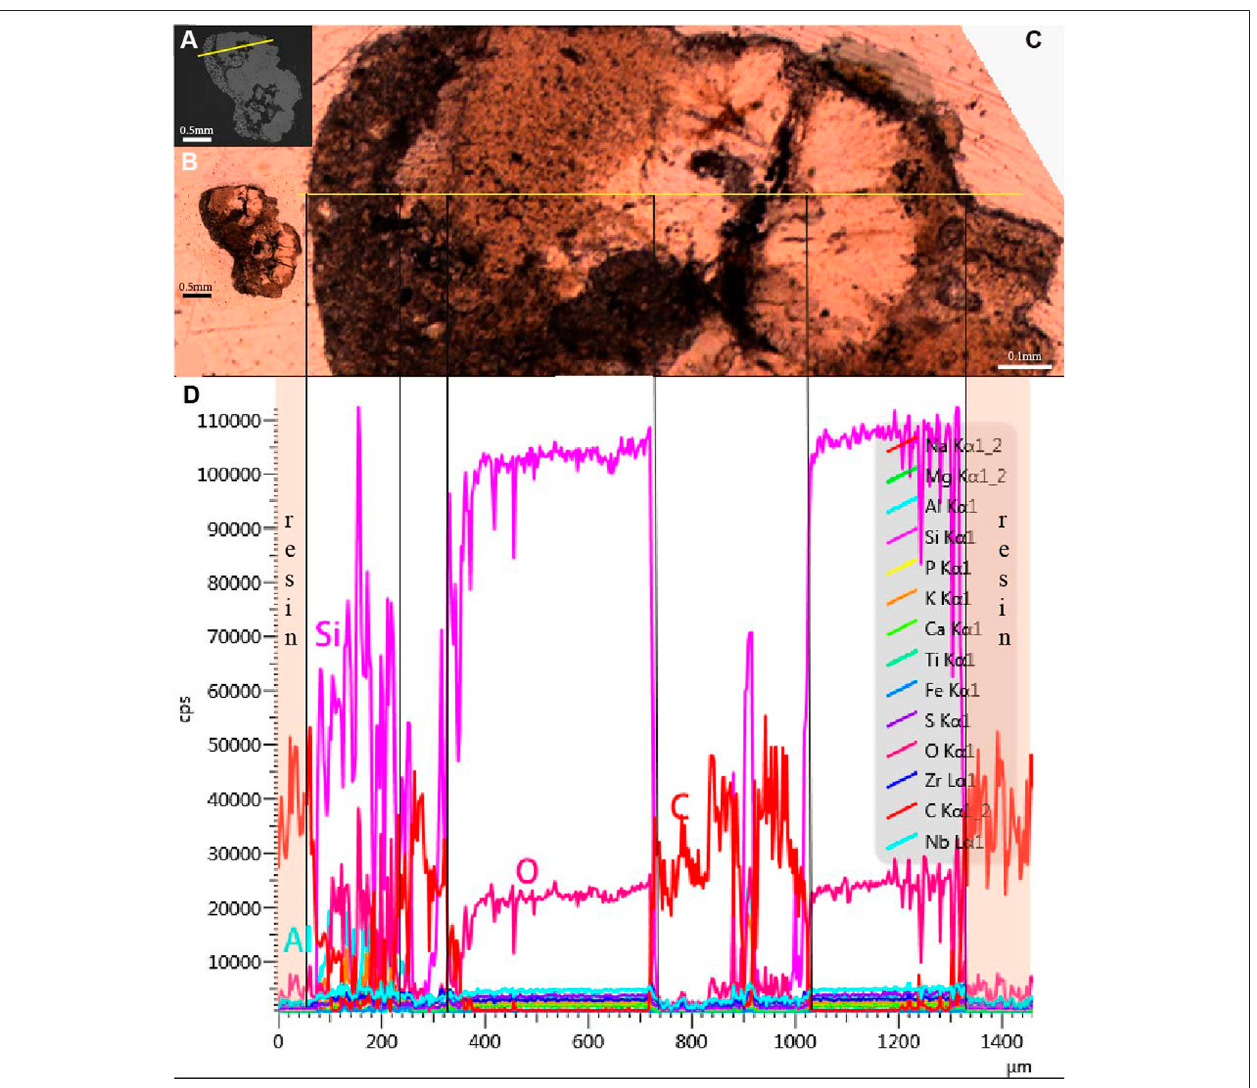
FIGURE 4 | EDS pro fi le of the purported gastroliths extracted from Bohaiornis guoi IVPP V17963. (A) . SEM photograph with yellow line indicating where the EDS pro fi le was taken; (B) . Ground section under microscope with natural light; (C) . Enlargement of the cross-section marked in A with the cross-section leveled horizontal; (D) . The EDSpro fi le of theline marked inA and Crevealingthe chemical compositionof major elements ofthe sample incounts per second (cps). ContentofSi, Oin the interior part are higher than that in the exterior part and in the intermediate region. Content of C in the intermediate region are the same as that of the resin.